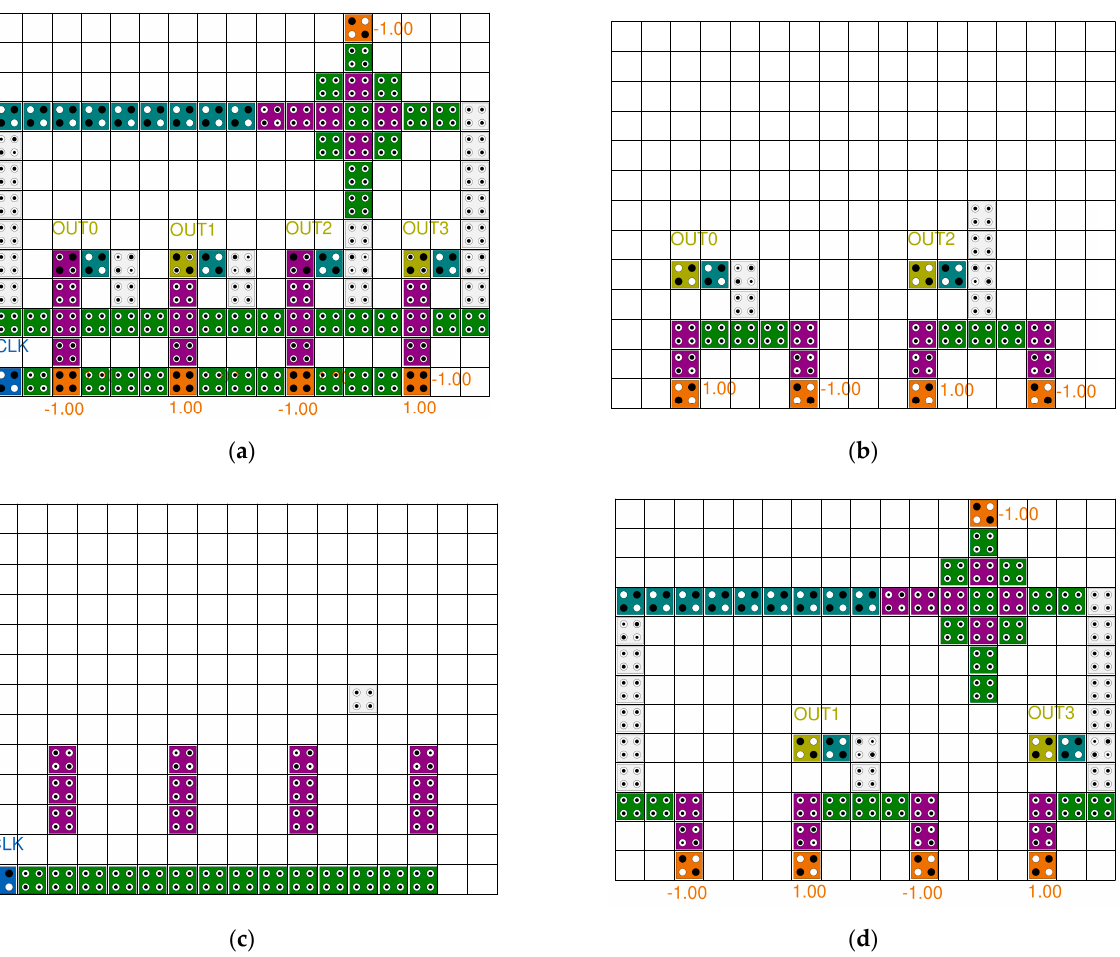
Figure 13. Proposed 4-bit LFSR structure: ( a ) Top view; ( b ) layer 1; ( c ) layer 2; and ( d ) layer 3.